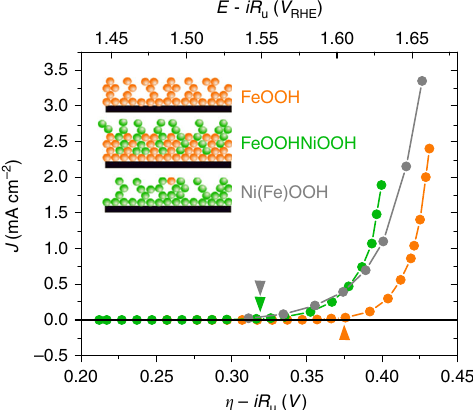
Fig. 1 Steady-state J – V performance for each electrocatalyst. Steady state J – V curves at pH 13 (0.1 M NaOH aqueous solution) for FeOOH (orange), FeOOHNiOOH (green) and Ni(Fe)OOH (grey). These were recorded by measuring the steady-state current at different applied potential under atmospheric conditions. The FeOOH and Ni(Fe)OOH fi lms are ~80 nm thick, while the FeOOHNiOOH fi lm is ~120 nm thick (Supplementary Figs. 1 and 2). The overpotential is estimated as: η = E RHE − 1.23 V and was corrected by the iR drop estimated by electrochemical impedance spectroscopy (EIS) measurements. Such J – V behaviour is typical of that reported previously for analogous Fe/Ni oxyhydroxide electrodes 19,28 . Arrows indicate the onset of the catalysis, which has been approximated to the potential at which the current reaches 20 µ A cm − 2 Inset: Schematic representation of the different samples studied in this work. Orange represents an Fe-based group and green a Ni-based